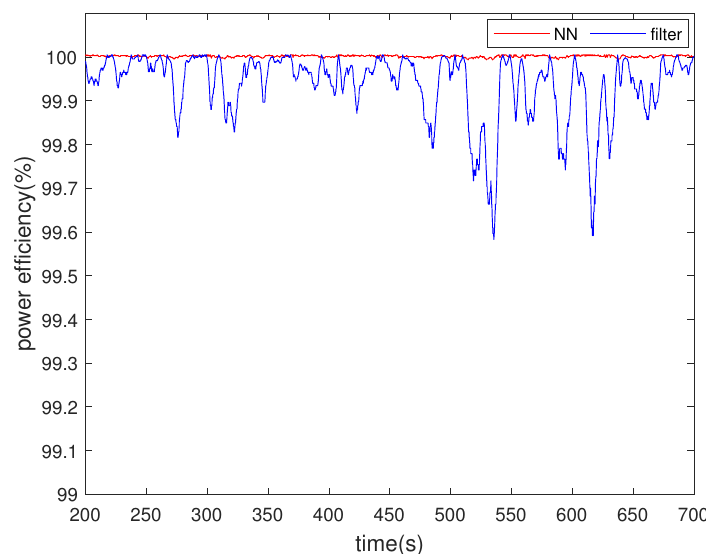
Figure 20. Power efficiency in below rated wind